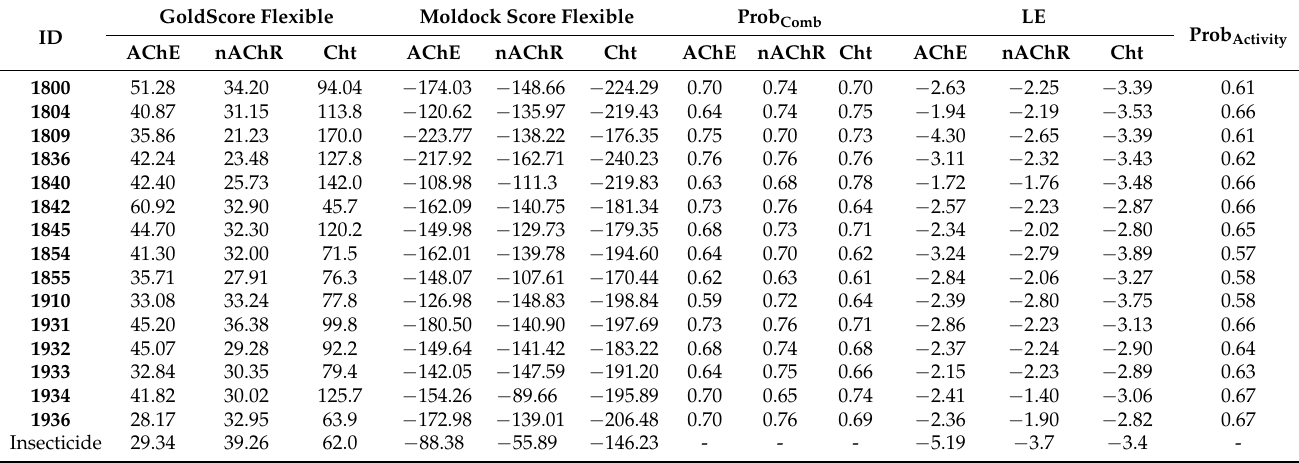
Table 4. Moldock Score and GoldScore values obtained from docking and combined probability values (Prob Comb ) between prediction models and molecular coupling analysis for potential activity against A. gossypii . In the table, only the Prob Comb only values considered active are presented. Data on the ligand efficiency (LE) of the compounds are also available in the table. GoldScore ID